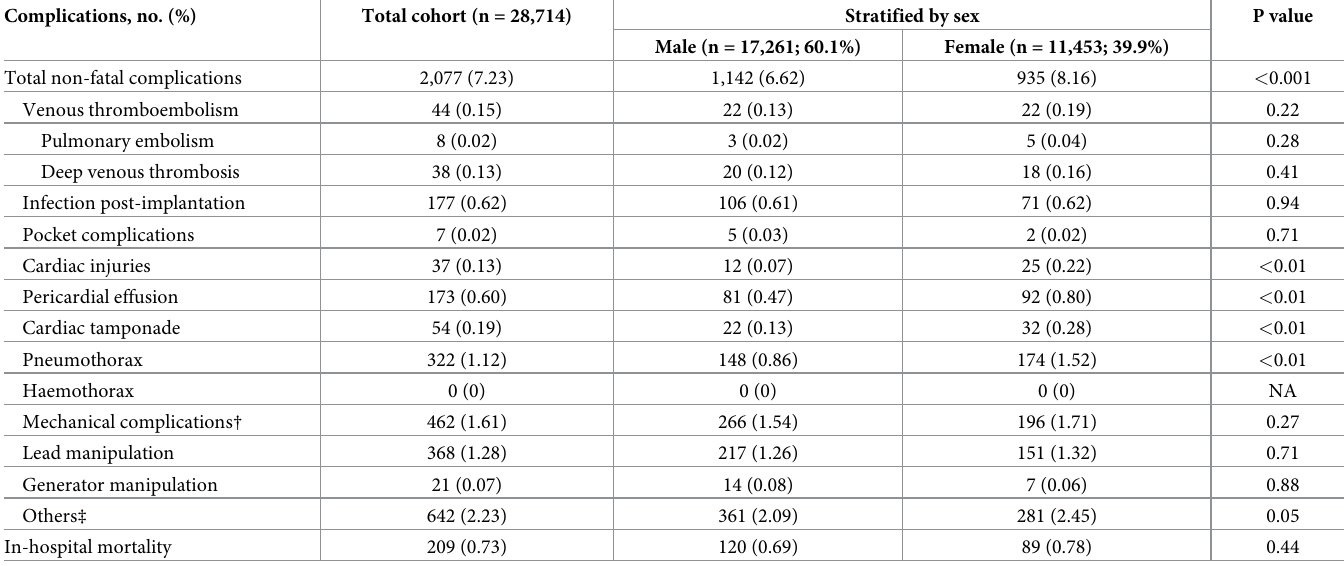
Table 2. In-hospital complications during permanent pacemaker implantation � . Complications, no.